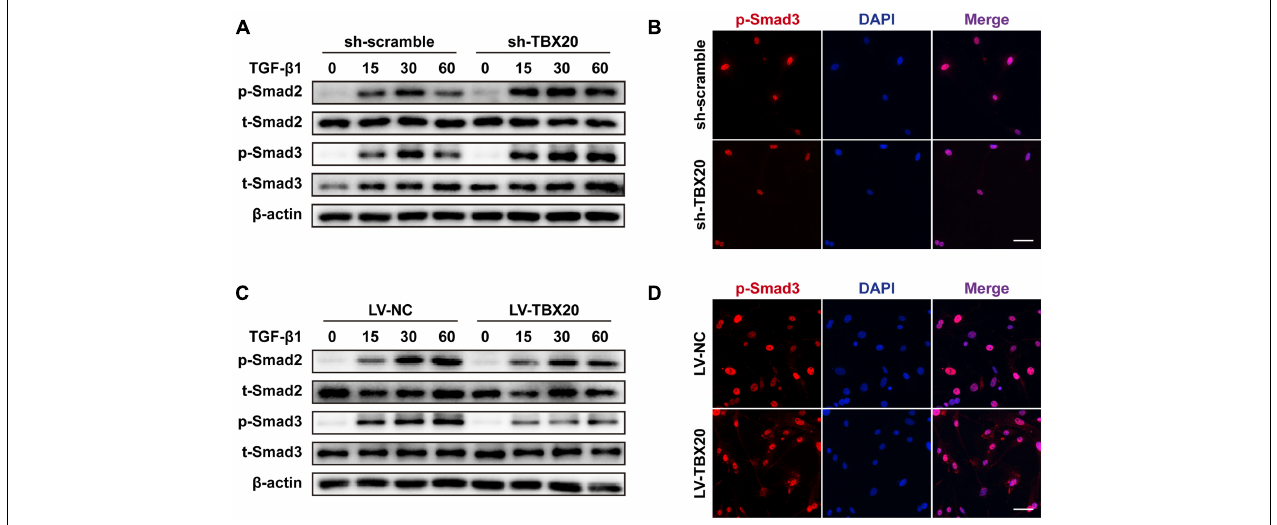
FIGURE 5 | TBX20 was important to the activation of Smad2/3 signaling during SMC differentiation. (A,C) PVASCs were incubated with 5 ng/mL TGF- β 1 after starving with 2% FBS medium for 24 h, and the samples were harvested at 15, 30, and 60 min. Western Blot analyses detected the phosphorylation of Smad2/3. (B,D) Immunofluorescence staining revealed that more Smad3 was translocated into the nuclei in the sh-TBX20 cells and less Smad3 was translocated into the nuclei in the LV-TBX20 cells. Scale bar = 50 µ m. Cell nuclei were stained with DAPI.